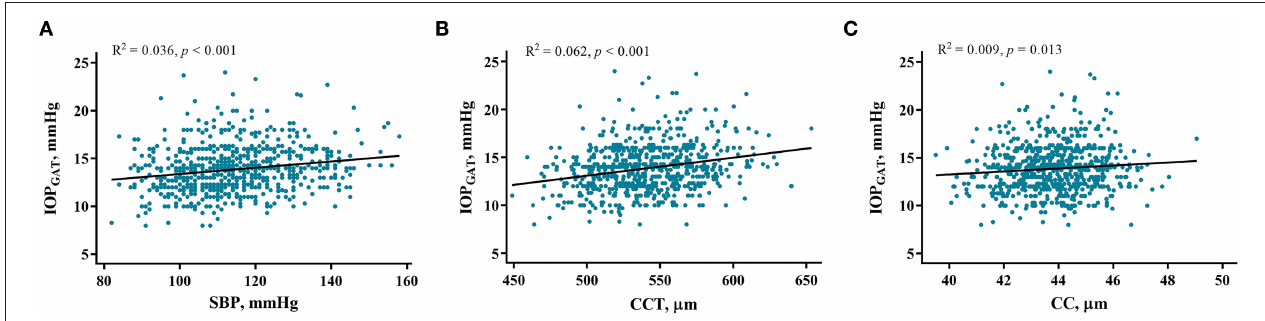
FIGURE 4 | Correlations between IOP GAT values and risk factors. Regression plots show systolic blood pressure (SBP) (A) , central corneal thickness (CCT) (B) , and corneal curvature (CC) (C) effect on IOP GAT with R 2 = 0.036, 0.062, and 0.009, respectively. The full lines indicate regression lines. IOP GAT , intraocular pressure measured with Goldmann applanation